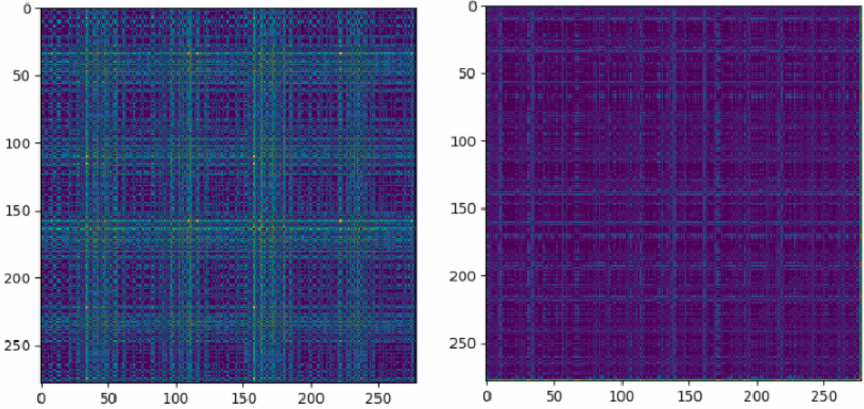
Figure 3. Recurrence plots with (Max–Min) preprocessing technique. Left: recurrence plot for fault condition (bearing axis deviation) motor. Right: recurrence plot for healthy condition motor.